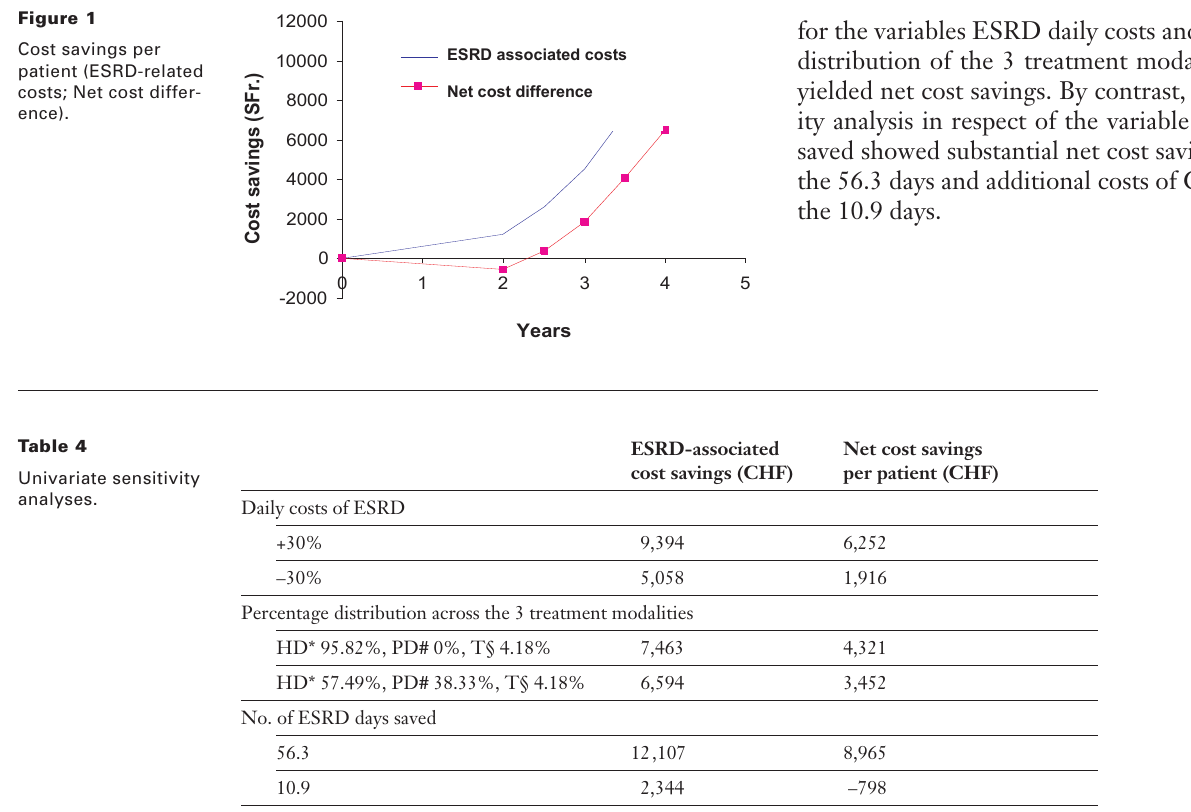
Cost savings per patient (ESRD-related costs; Net cost differ- ence).